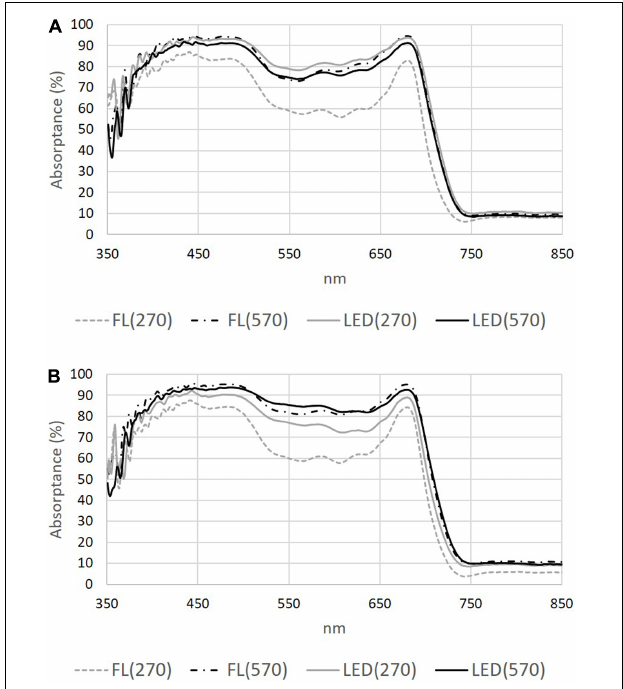
FIGURE 3 | Leaf absorptance from 350 to 850 nm of red lettuce grown under different light sources (FL, compact fluorescence tubes and LED) at two irradiance levels (270 and 570 µ mol m − 2 s − 1 ). (A) measurements taken on the adaxial side of leaf number four, (B) measurements taken on the abaxial side of leaf number four ( N = 3). Absorptance was determined from reflectance and transmittance data measured on the leaf at 30 DAS using a Halogen lamp.